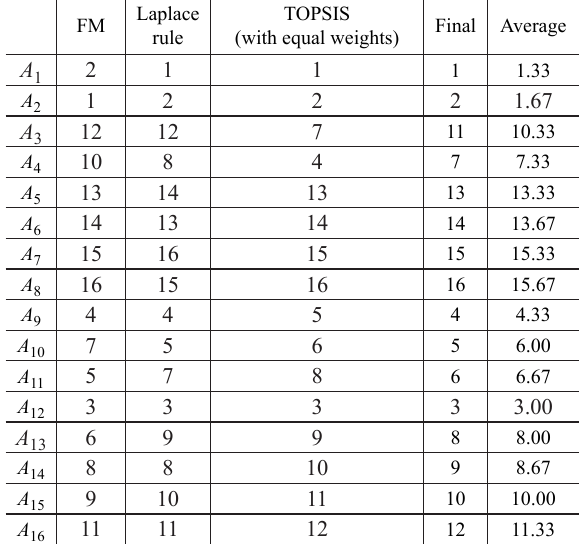
Table 6. Ranking of alternatives when criteria weights are not